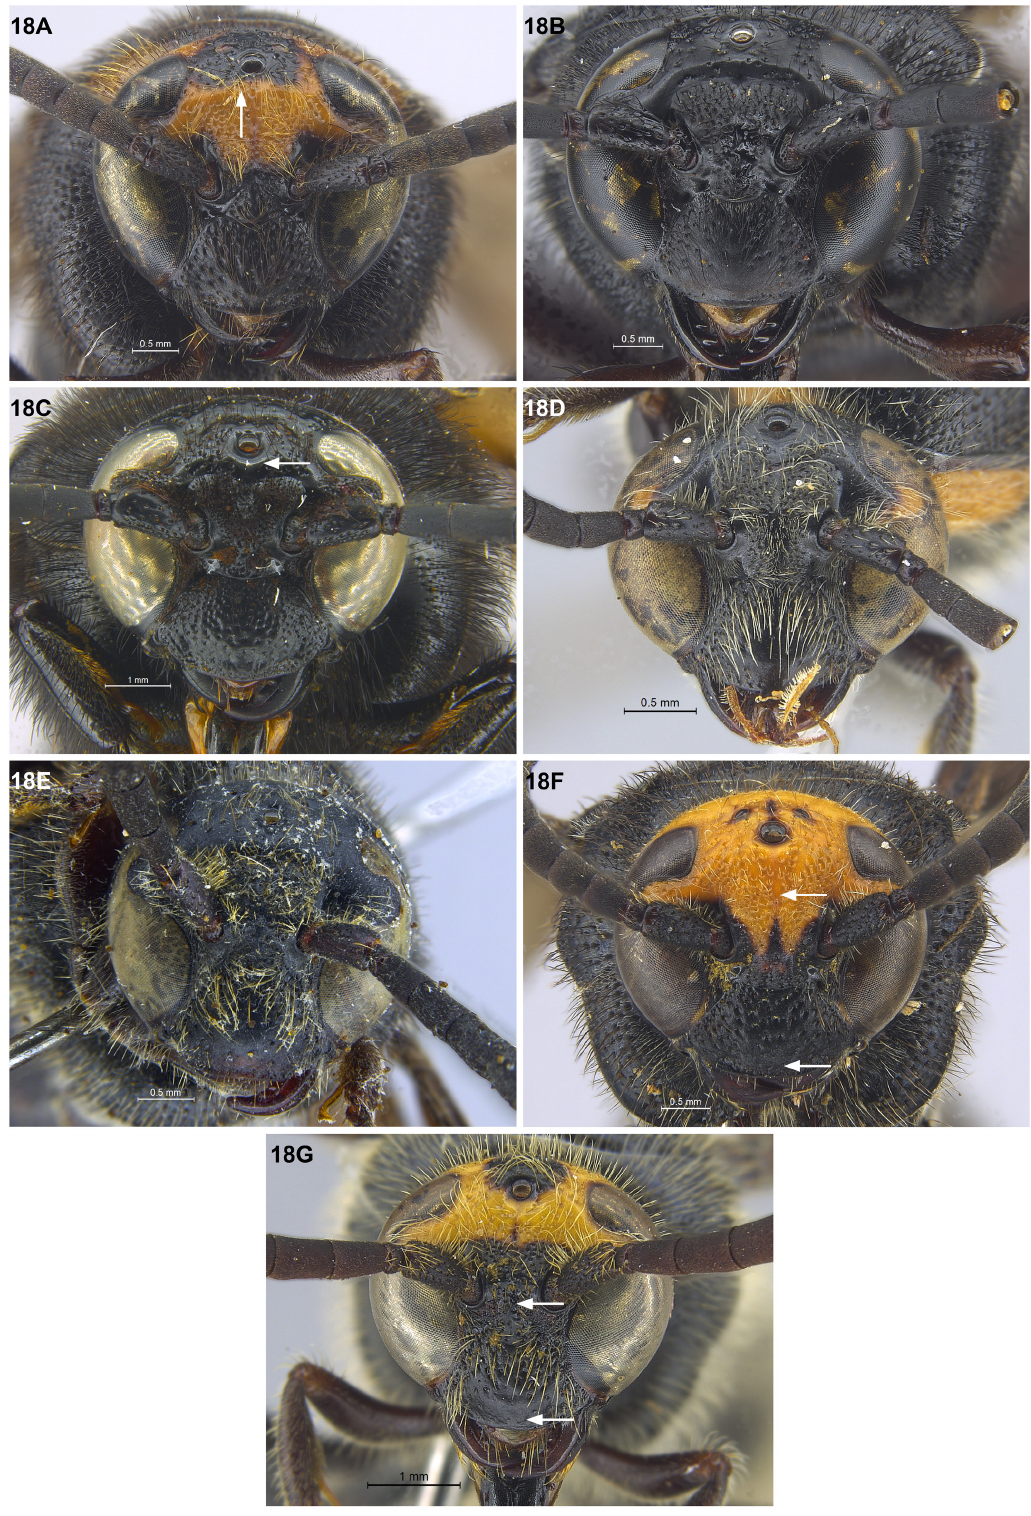
Fig. 18. Males, face. A . Carinoscolia junnanensis (Betrem, 1928). B . Liacos erythrosoma (Burmeister, 1854). C . Megascolia azurea (Christ, 1791). D . Scolia binotata Fabricius, 1804. E . Sc. laeviceps Smith, 1855. F . Sc. pakshaoensis sp. nov., paratype (CBC). G . Sc . superciliaris de Saussure & Sichel, 1864